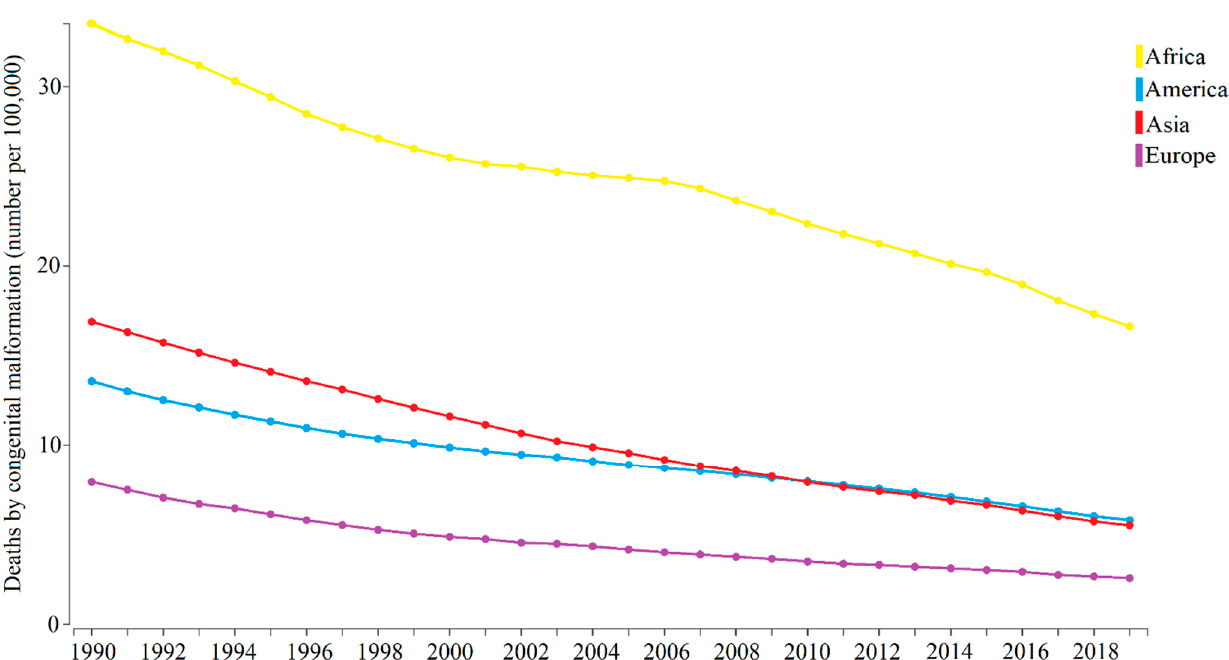
Figure 3. Deaths by congenital malformation over the years in Africa, America, Asia, and Europe, according to the Institute for Health Metrics and Evaluation.